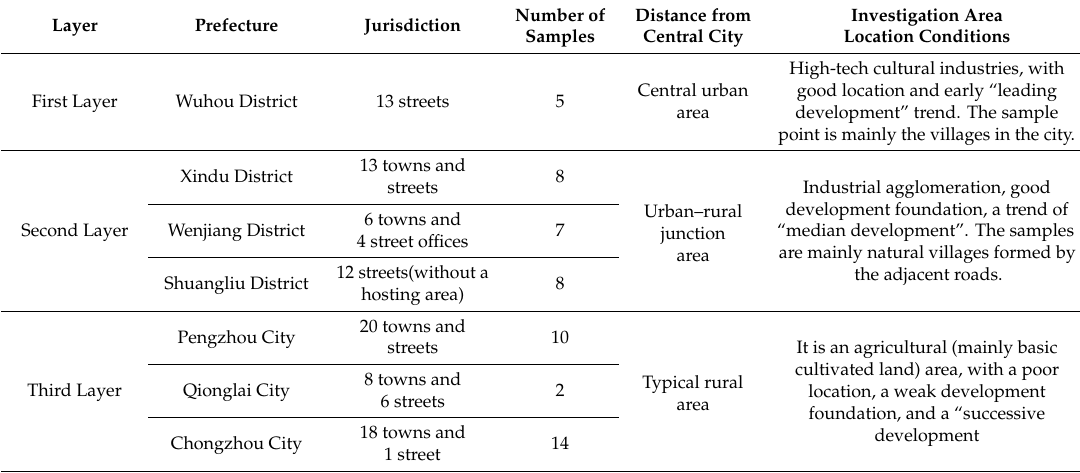
Table 1. Typical regions selected within the circle layers for empirical